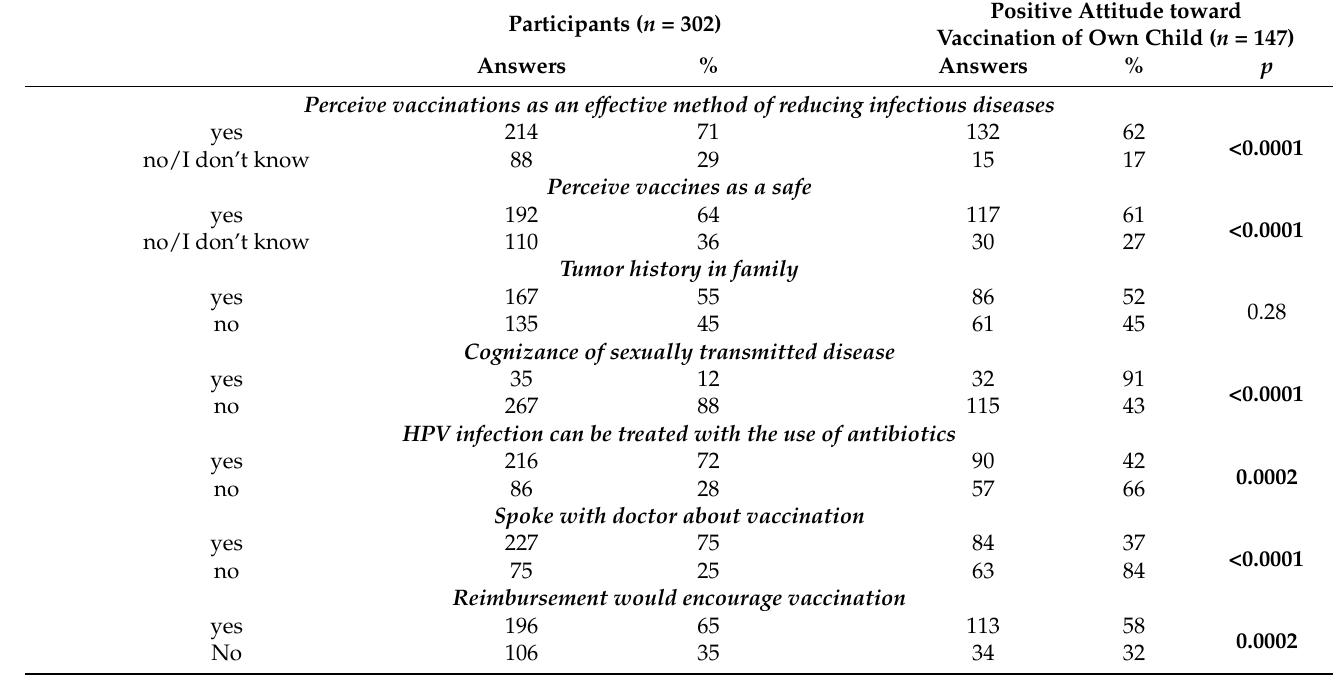
Positive Attitude toward Vaccination of Own Child ( n = 147)